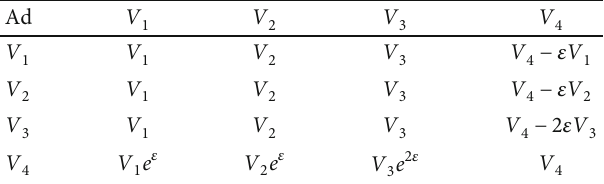
Table 2: Adjoint representation table.